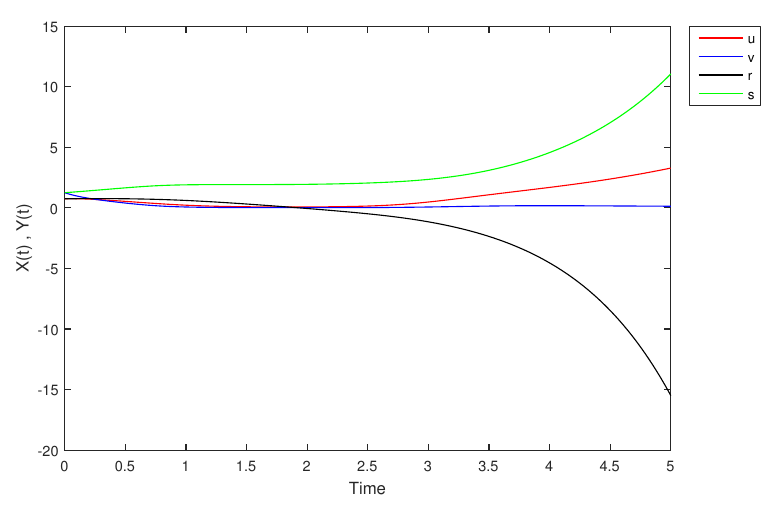
Figure 8. The solution of (6) at α = 0.5.